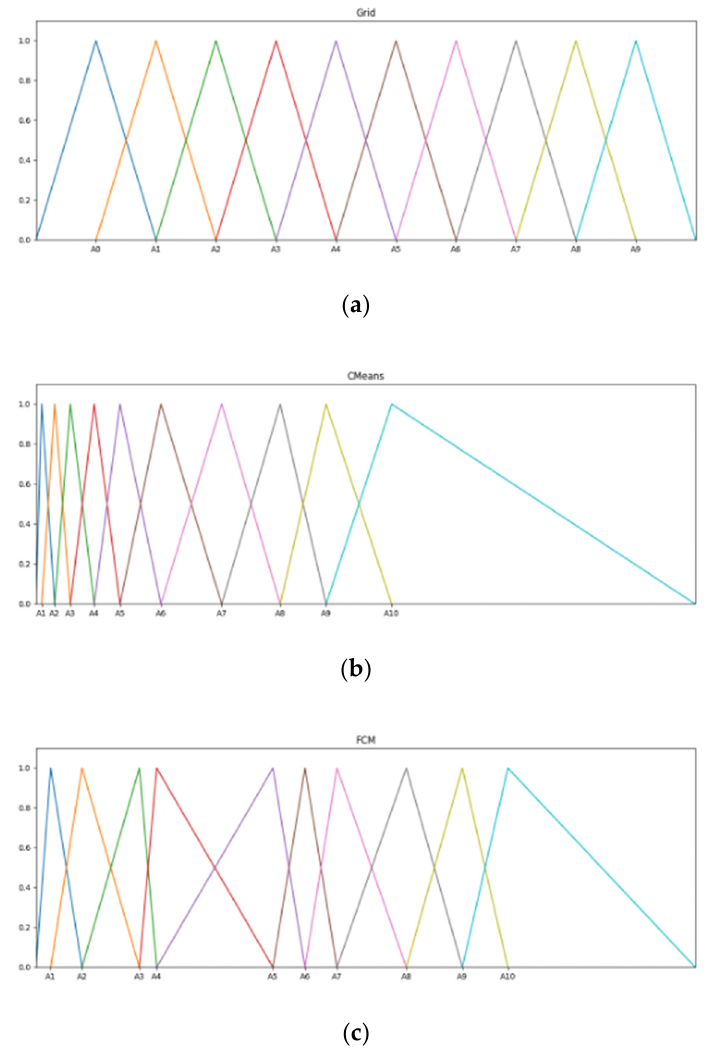
Figure 2. Fuzzing GDP per capita using: ( a ) Grid, ( b ) k-Means, ( c ) fuzzy C-means. Table 5. Comparison of fuzzing GDP per capita by different partitioners